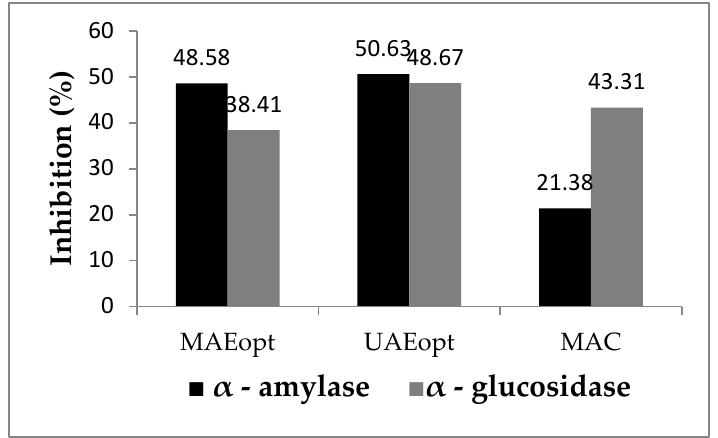
Figure 2. Inhibitory potential of horehound extracts for α -amylase and α -glucosidase. The investigated UAEopt, MAEopt and MAC differ significantly in their chemical